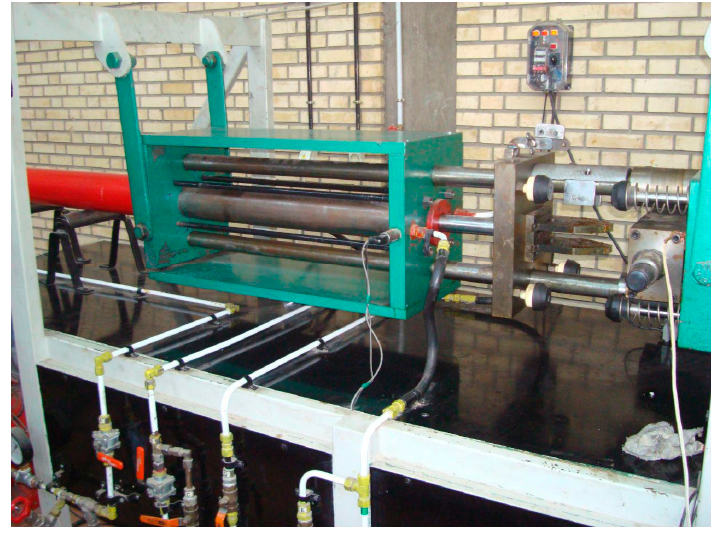
Figure 3. Flying Wage testing apparatus